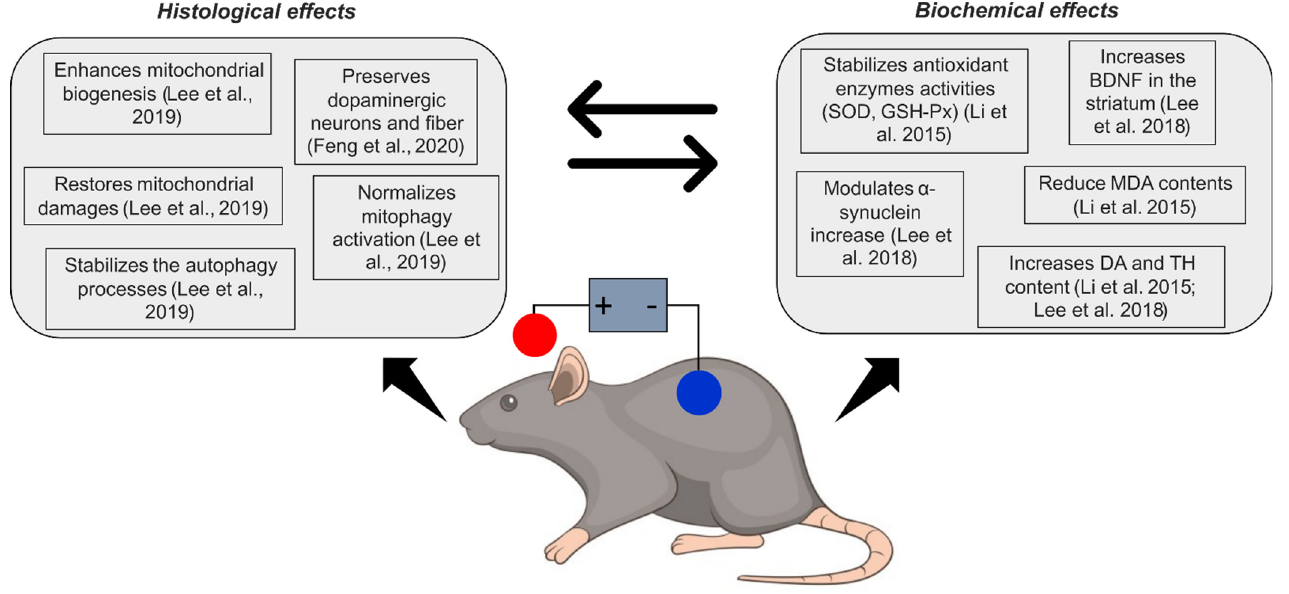
Figure 1. Schematic overview of neuroprotective effects of tDCS in animal models of Parkinson’s disease. SOD = superoxide dismutase; GSH-Px = glutathione peroxidase; BDNF = brain-derived neurotrophic factor; MDA = malonaldehyde; DA = dopamine; TH = tyrosine hydroxylase. Feng et